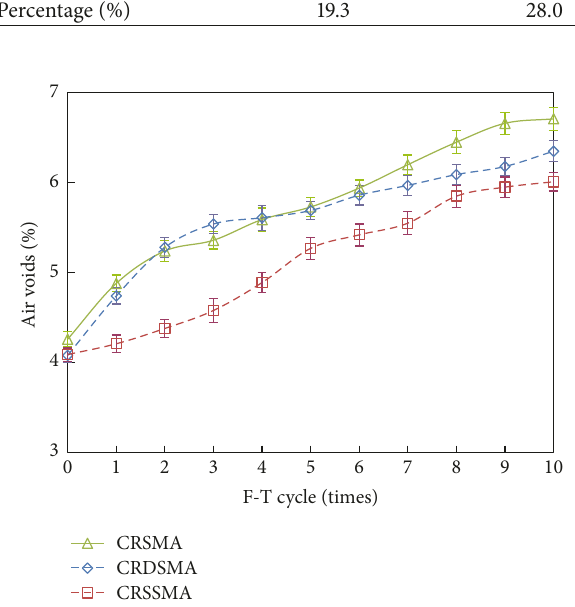
Figure 4: Air voids (Mean ± SD) of CRSMA, CRDSMA, and CRSSMA before and after F-T cycles.